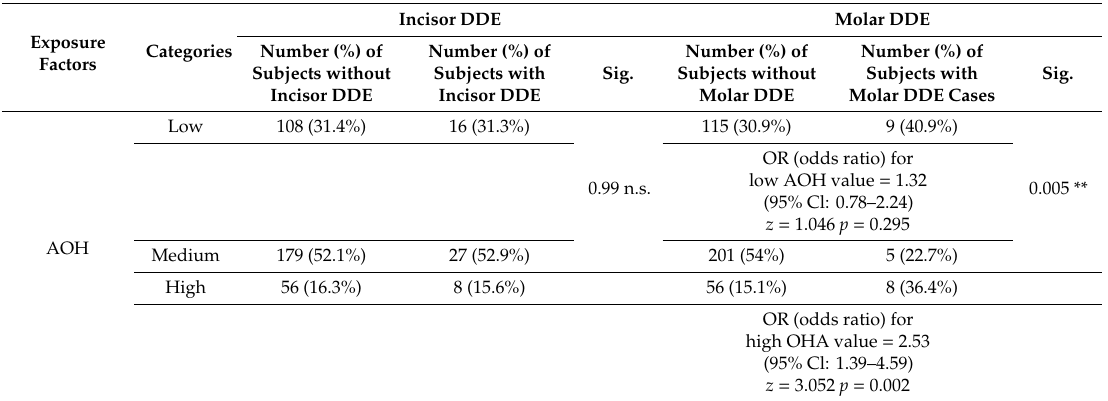
Table 2. Report of number of children (and percentage among cases and controls) for each exposure category with significant associations with developmental enamel defects